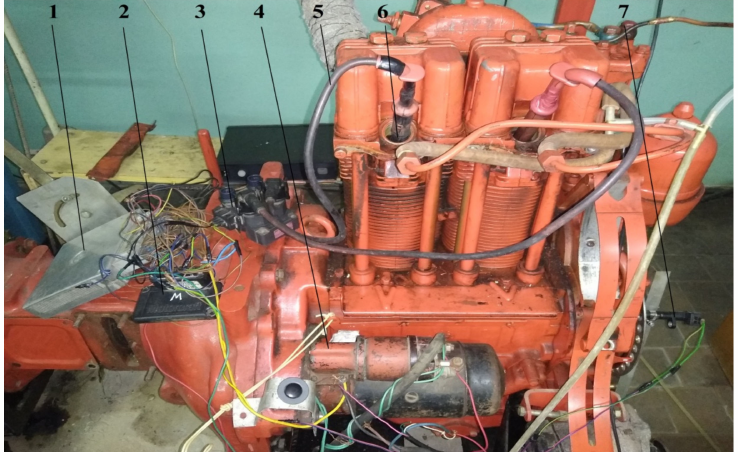
Figure 5. Ignition system of the converted diesel engine D21A1: 1—electronic control unit; 2— commutator; 3—ignition module; 4—starter; 5—high-voltage wires; 6—spark plugs; 7—sensor of crankshaft position.